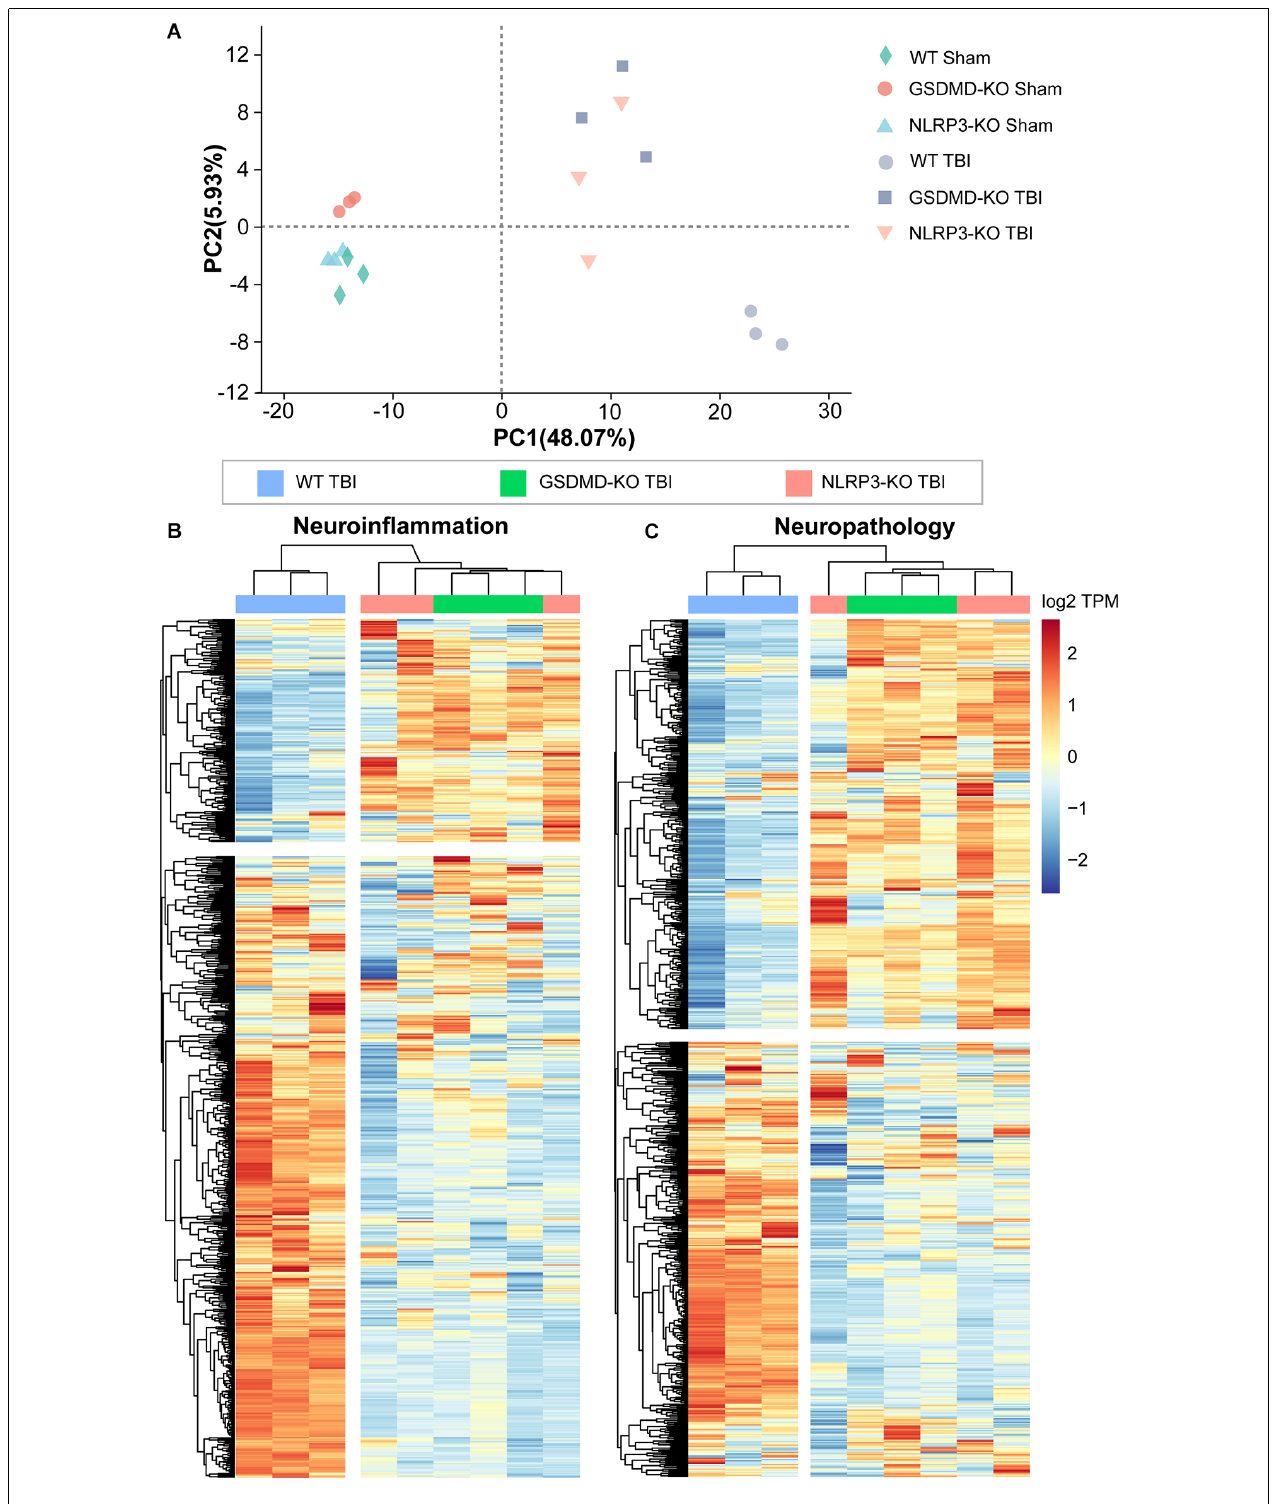
FIGURE 8 | Both GSDMD-KO and NLRP3-KO reversed the global expression of neuroinflammation- and neuropathology-related genes at 3 days after TBI. (A) PCA analysis of RNA-seq data from WT, GSDMD-KO, and NLRP3-KO mice at 3 days after sham or TBI treatment ( n = 3). (B,C) Heatmap analysis of neuroinflammation- and neuropathology-related gene expression patterns from WT, NLRP3-KO, and GSDMD-KO mice at 3 days after TBI.